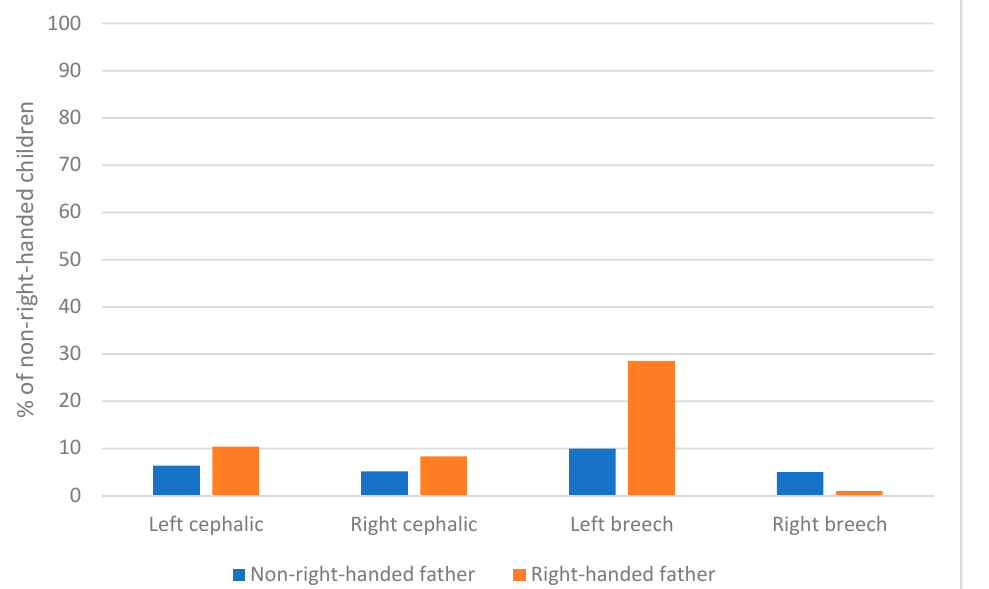
Figure 7. ( a ) Distribution of left-handed and right-handed children (X axis) as a function of father’s handedness (Y axis). ( b ) Distribution of left-handed and right-handed children (X axis) as a func- tion of presentation at birth (Y axis).